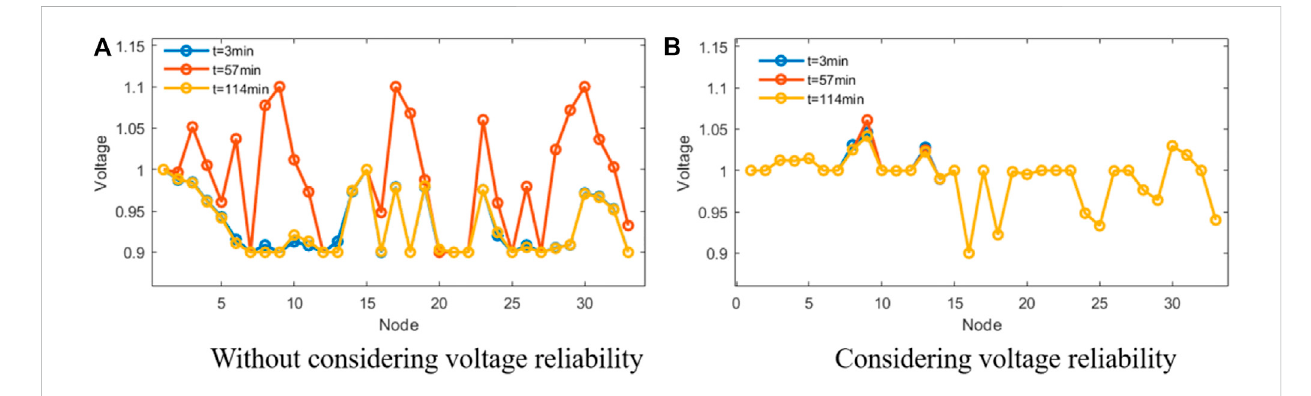
FIGURE 10 Comparison of voltage reliability.